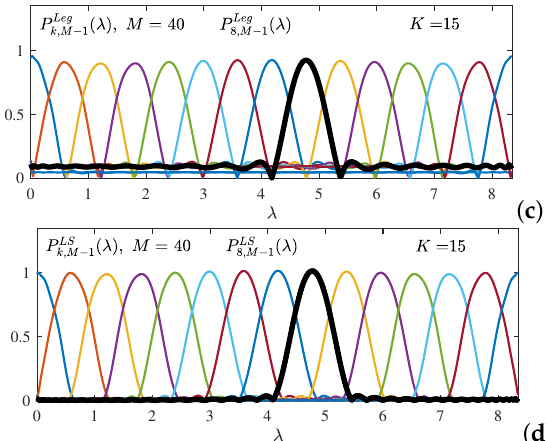
Figure 16. Spectral bandpass transfer functions used for calculation of the LGFT and their polynomial approximations. ( a ) Spectral functions of the Hann form with K = 15. ( b ) Approximation of spectral transfer functions based on Chebyshev polynomial with M = 40. ( c ) Legendre-polynomial-based approximations of spectral transfer functions with M = 40. ( d ) Least squares approximation of spectral transfer functions with M = 40. For convenience, function H 8 ( λ ) is designated with a thick black line on each panel.